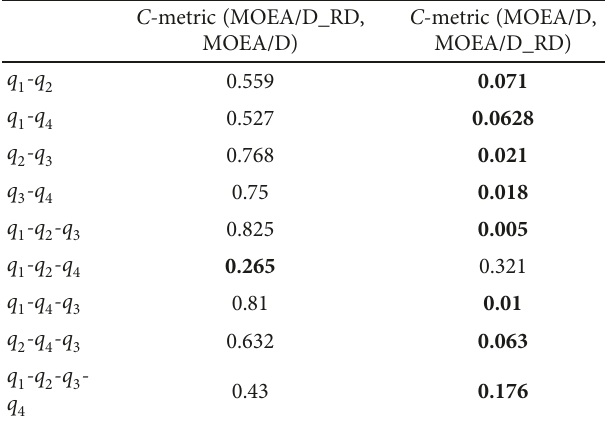
Table 1: Comparison of C -metric of MOEA/D_RD and MOEA/D.